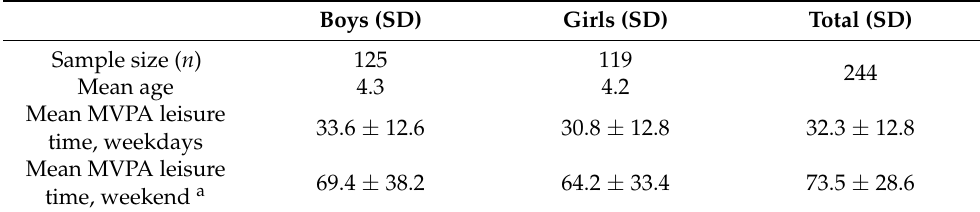
Table 1. Descriptive characteristics of children’s MVPA level at leisure.